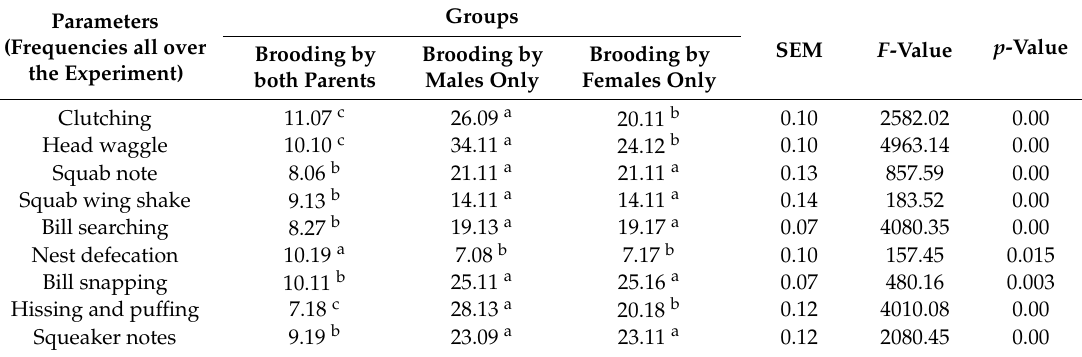
Table 2. E ff ect of pigeon parent sex on squab behavior during the brooding period.